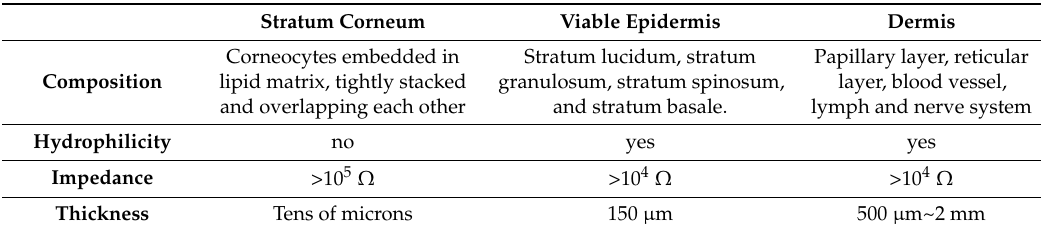
Table 1. Comparison between different skin